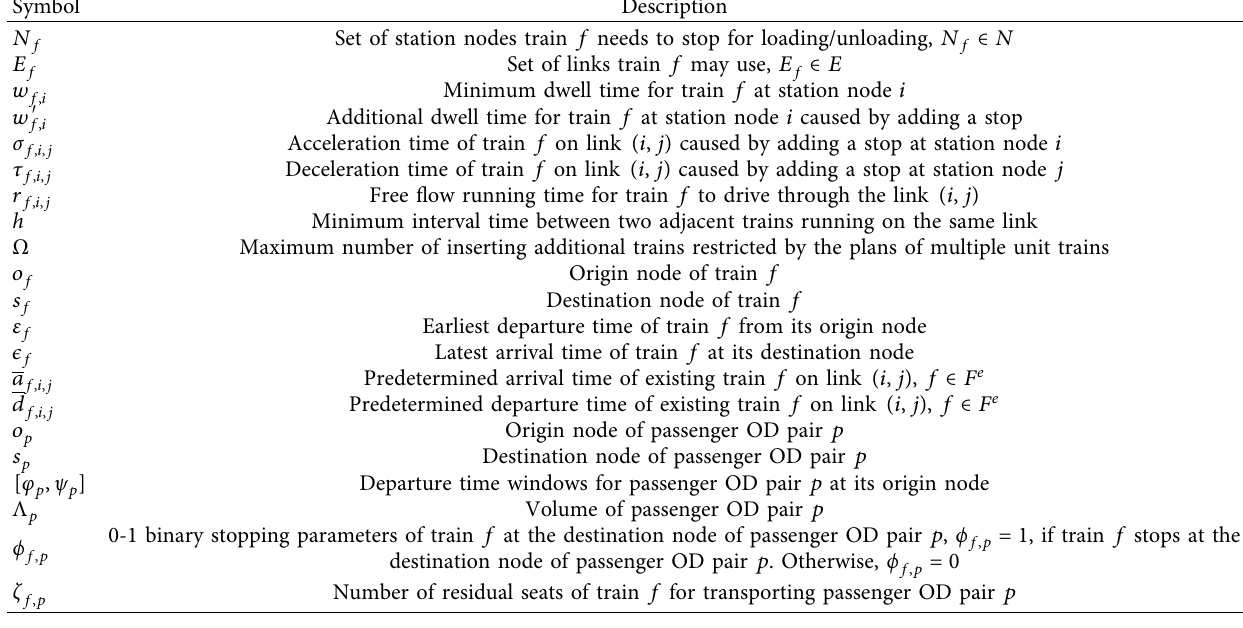
Table 1: Input parameters.